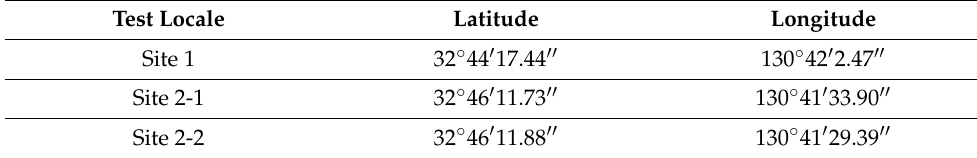
Table 2. Location of each site investigated for this